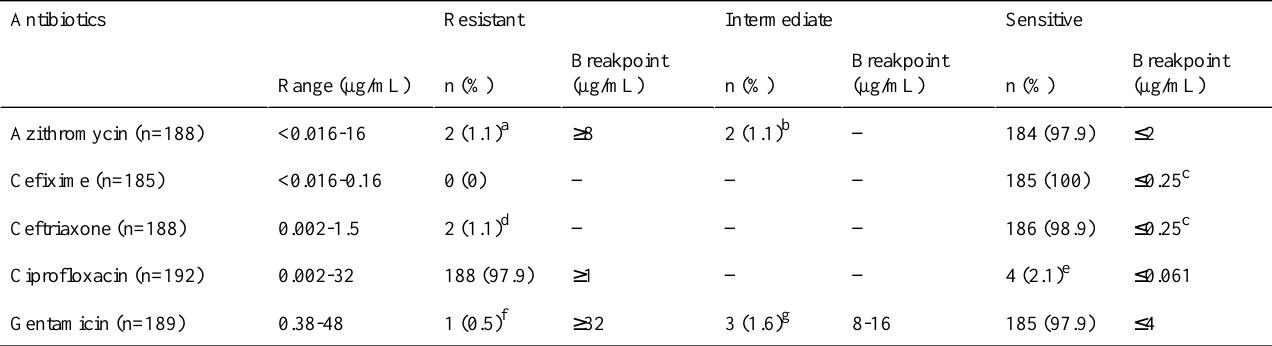
Table 3. Etest resistance